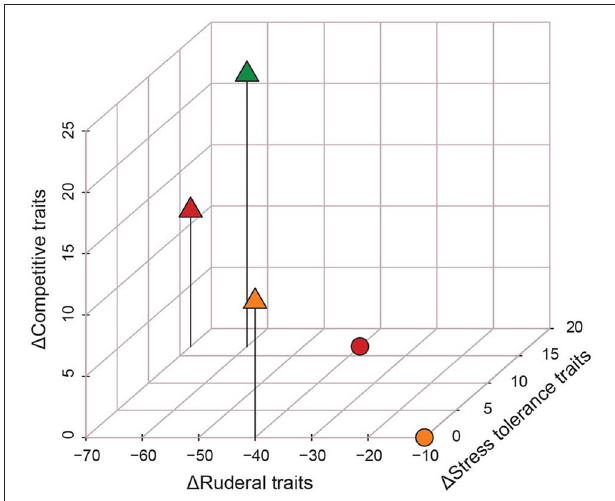
FIGURE 3 | Three-dimensional representation of change ( 1 ) in the number of functional traits for each microcosm treatment relative to the base-line soils (i.e., no-Cd bulk soils). Axis have been scaled by the number of traits detected for each CSR class. “ ◦ ” indicate bulk-soil community samples, “ 1 ” indicate rhizosphere community samples. Color is indicative of Cd treatment: Green = 0mg Cd kg − 1 soil; Amber = 20mg Cd kg − 1 soil; Red = 100mg Cd kg − 1